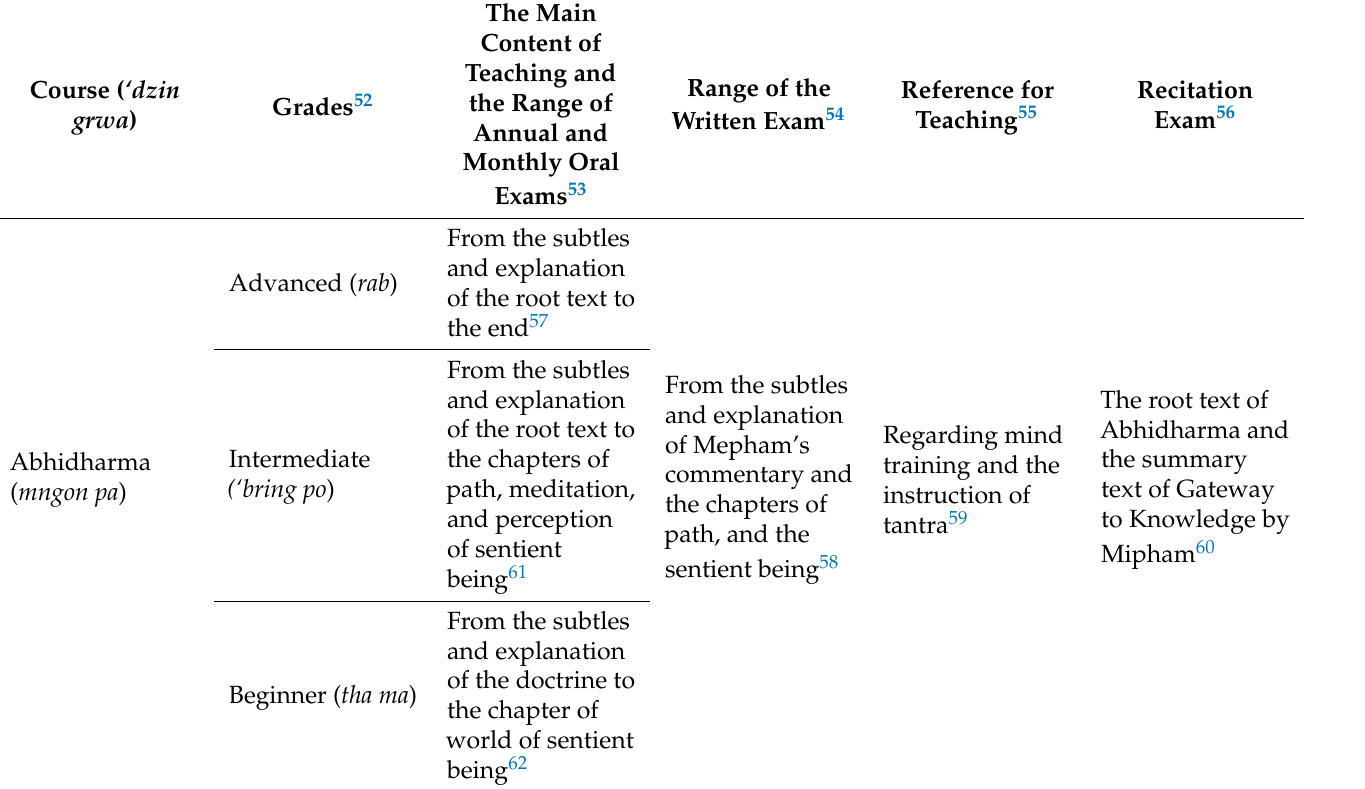
Table 7. Example of the main subjects of teaching and exams in 2017 51